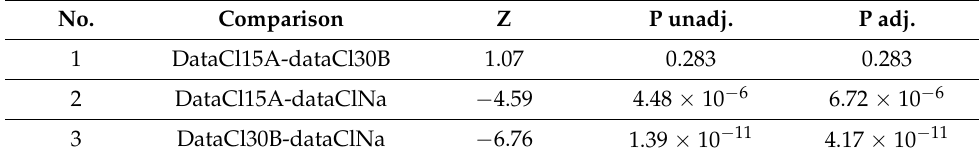
Table 2. Results of Dunn’s test for multiple comparisons.